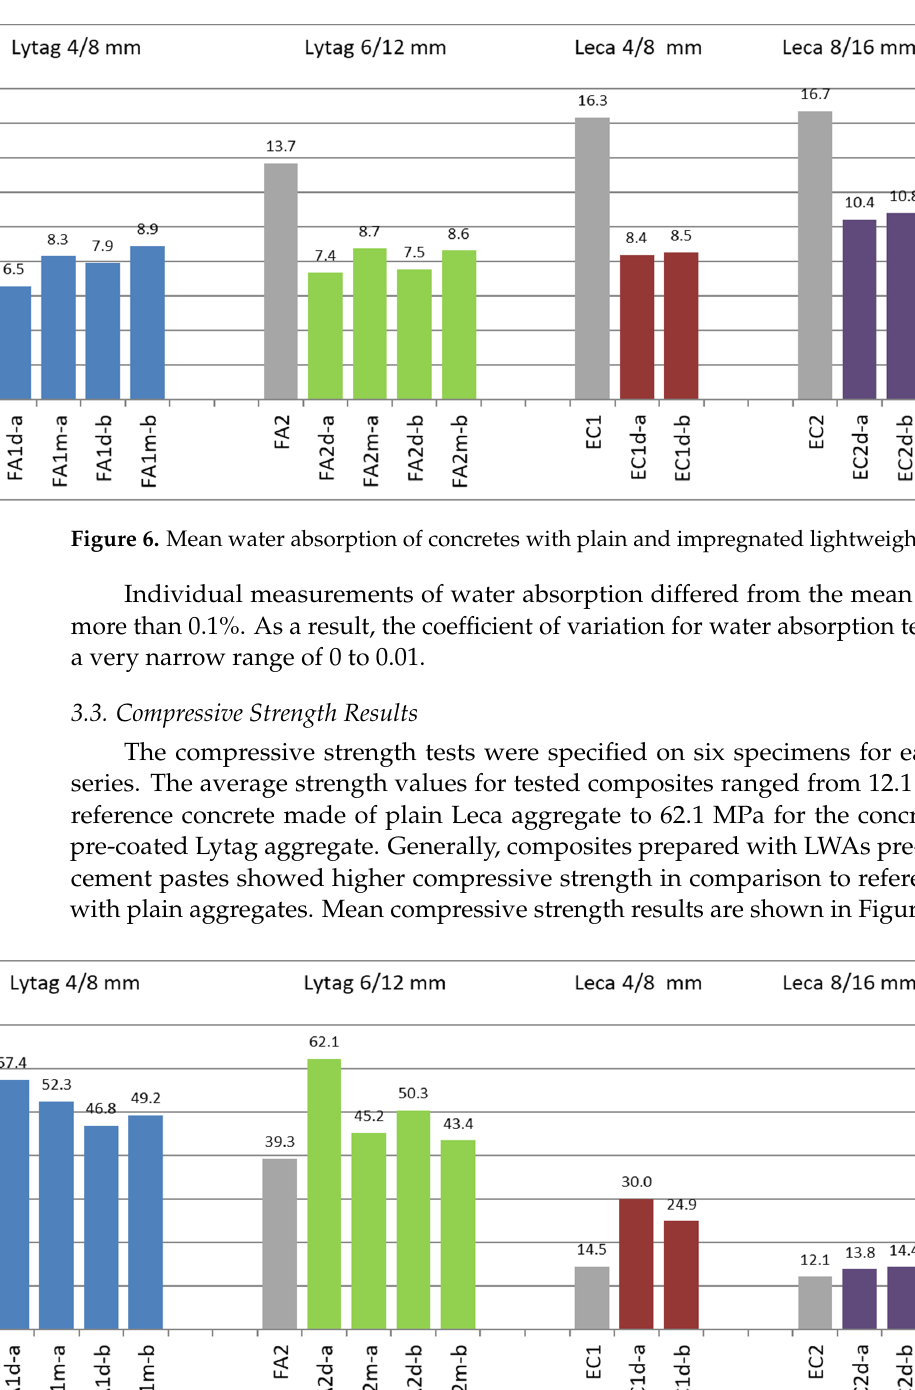
Figure 7. Mean compressive strength of concretes with plain and impregnated lightweight aggre-